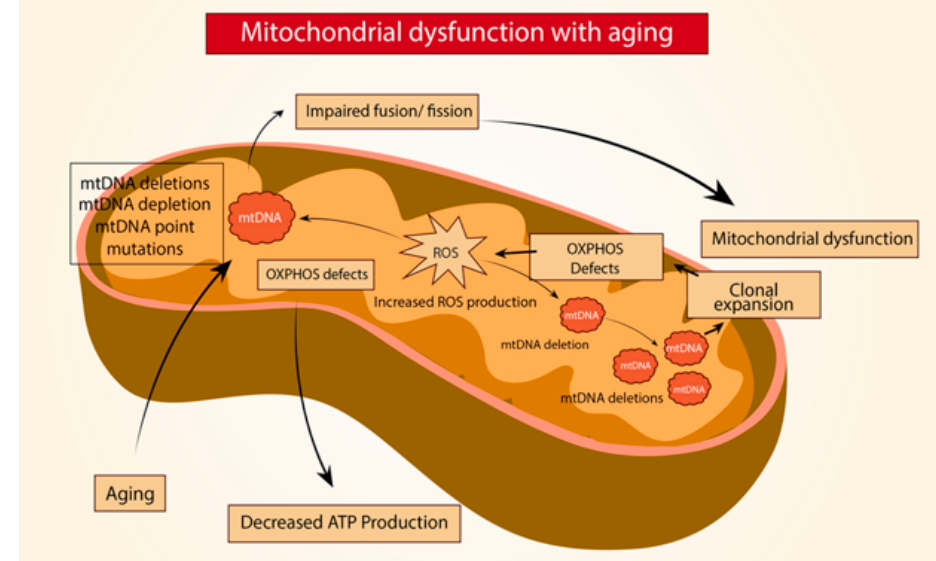
Figure 2. Mitochondria dysfunction with aging. In aging, alterations of the mitochondria DNA (mtDNA) such as deletions, depletion or point mutations can lead to defects in the mitochondria oxidative phosphorylation system (OXPHOS) decreasing ATP production and increasing reactive oxygen species (ROS) production, generating further mtDNA damage, causing impaired fusion/fission and ultimately leading to mitochondrial dysfunction.